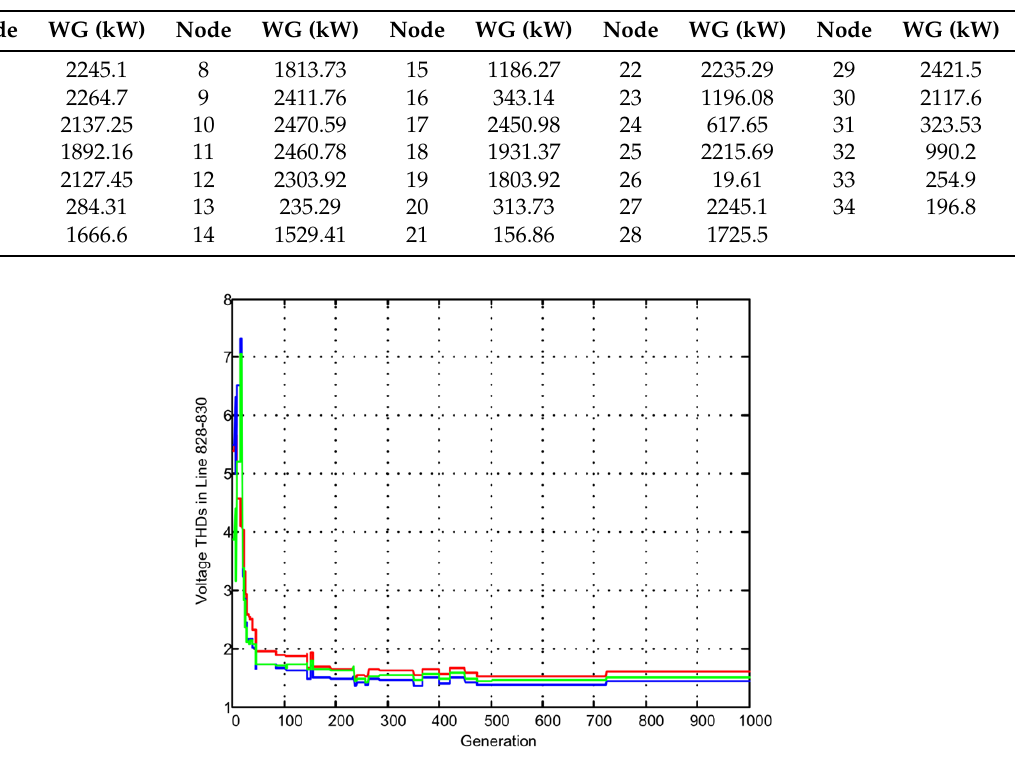
Figure 8. Voltage THD over GA iteration at branch 828–830.